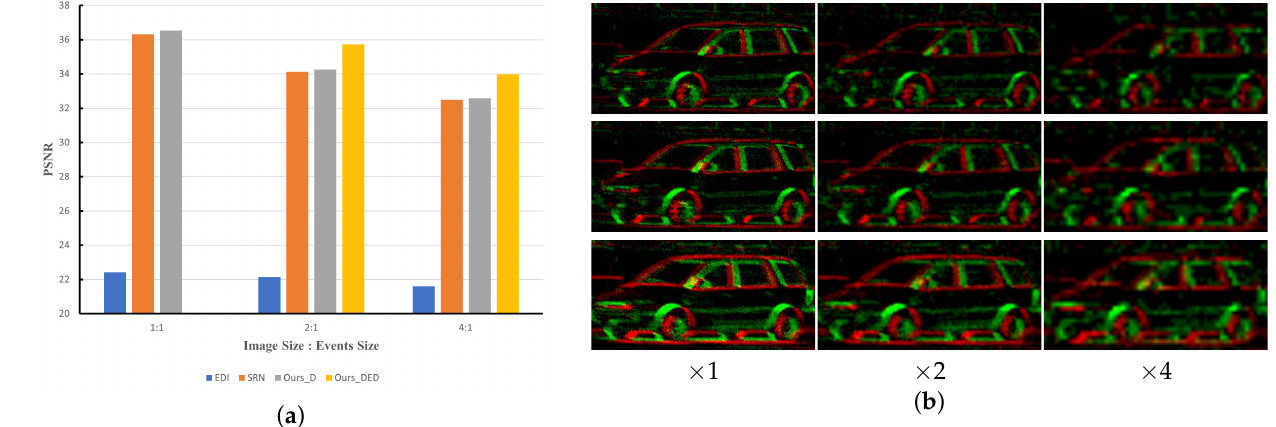
Figure 2. ( a ) The image deblurring performance of EDI [15,21] and our method in a different setting, in terms of PSRN; ( b ) The event sequence in a different spatial resolution. The first column is the event sequence that was simulated with a video in GoPro [20] in the original spatial resolution while the event sequences in the next two columns are simulated with the same video that has been downsized to × 2 and × 4, respectively. This shows that events with low-resolution still hold as much rich temporal information as the high-resolution events, which is very helpful for image